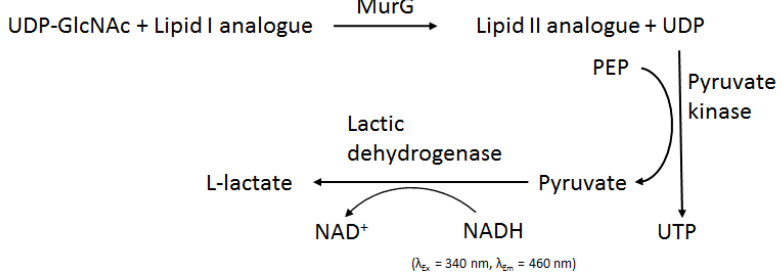
Figure 8. Fluorescence coupled assay for MurG. The figure is adapted from [88].